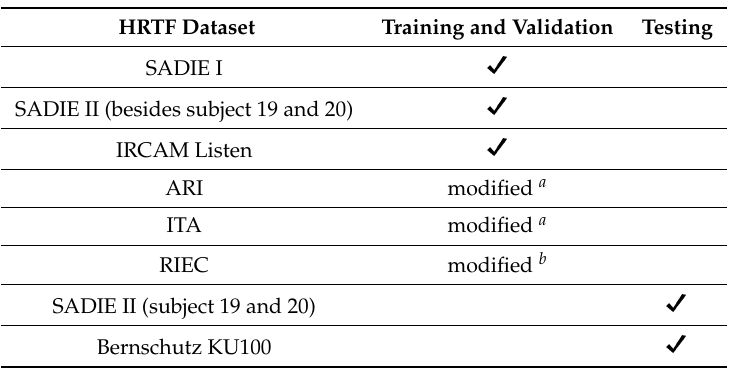
Table 3. A summary of data